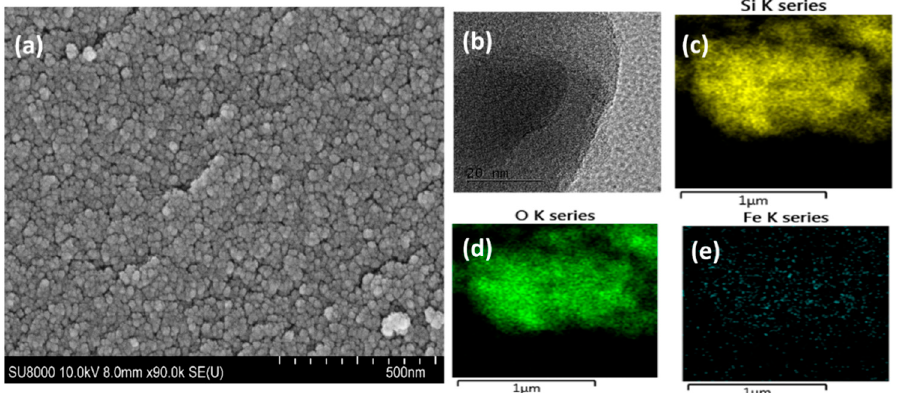
Figure 2. ( a ) SEM, ( b ) TEM, ( c – e ) elemental spectrum of Fe 2 O 3 /SiO 2 .